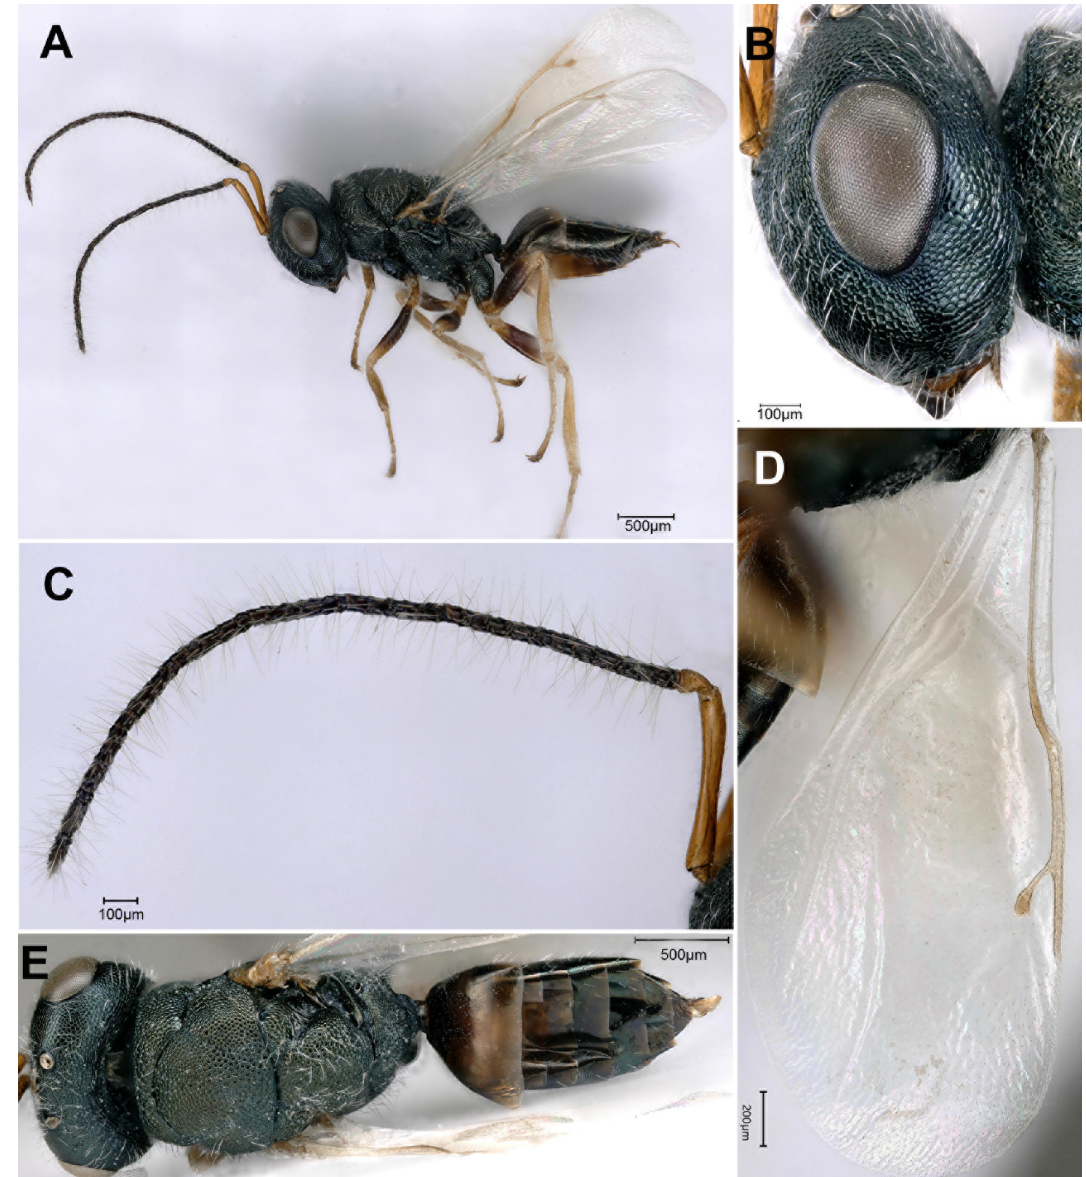
Fig. 14. Norbanus persicus Lotfalizadeh & Rasplus sp. nov., paratype, ♂ (HMIM). A . Lateral view. B . Head in lateral view. C . Antenna. D . Fore wing. E . Dorsal